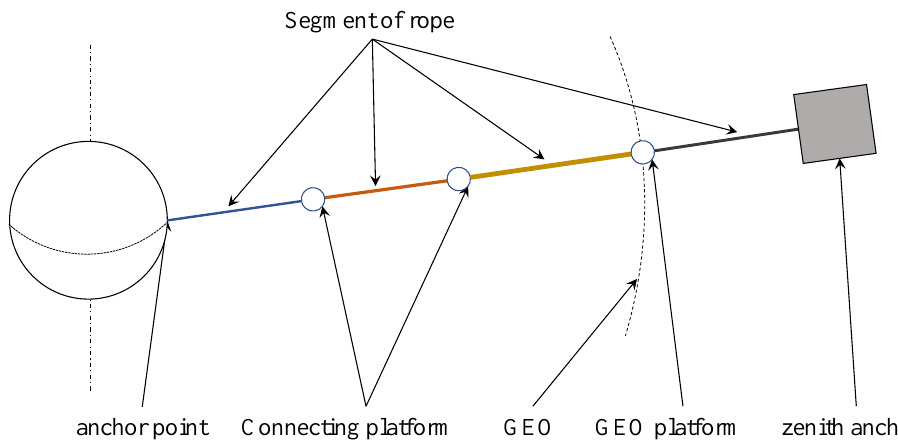
Figure 1. Schematic diagram of segmented space elevator system model.